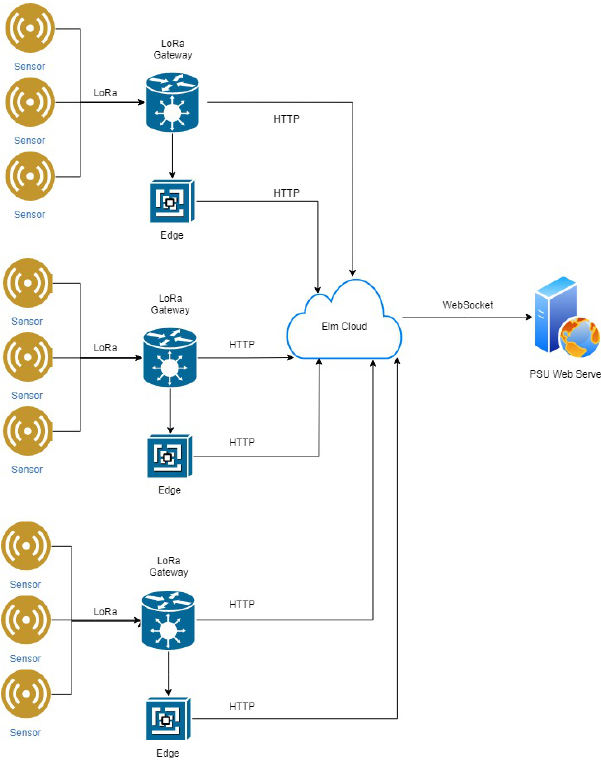
Figure 2. Flow diagram of the software